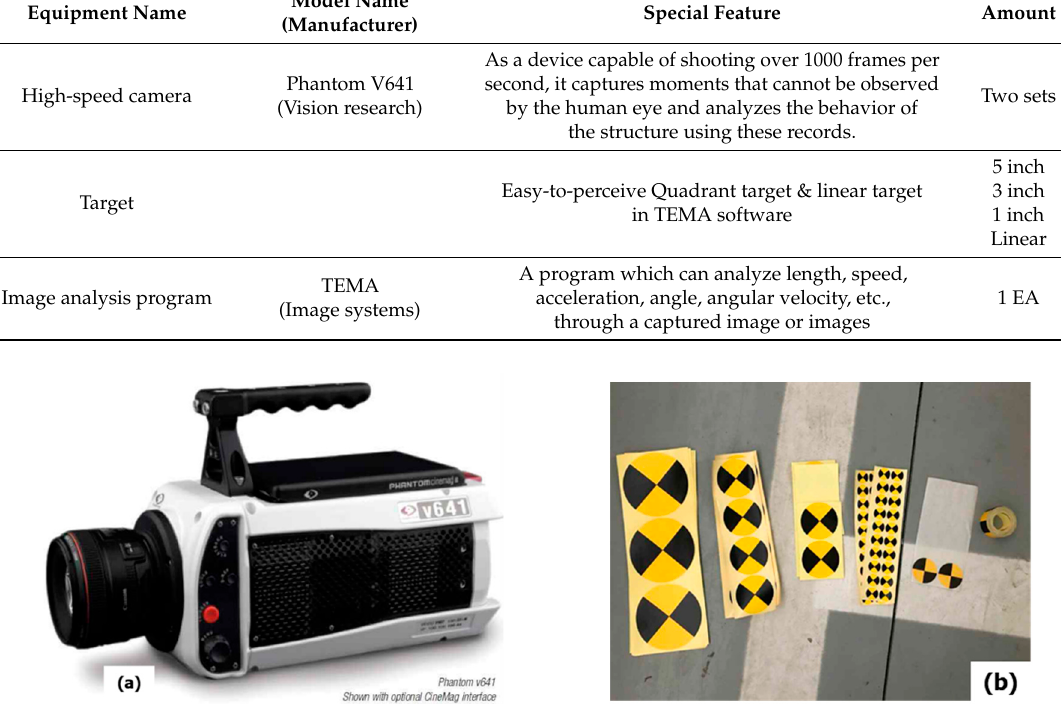
Table 2. Equipment and features used in high-speed camera shooting and image analysis. Equipment